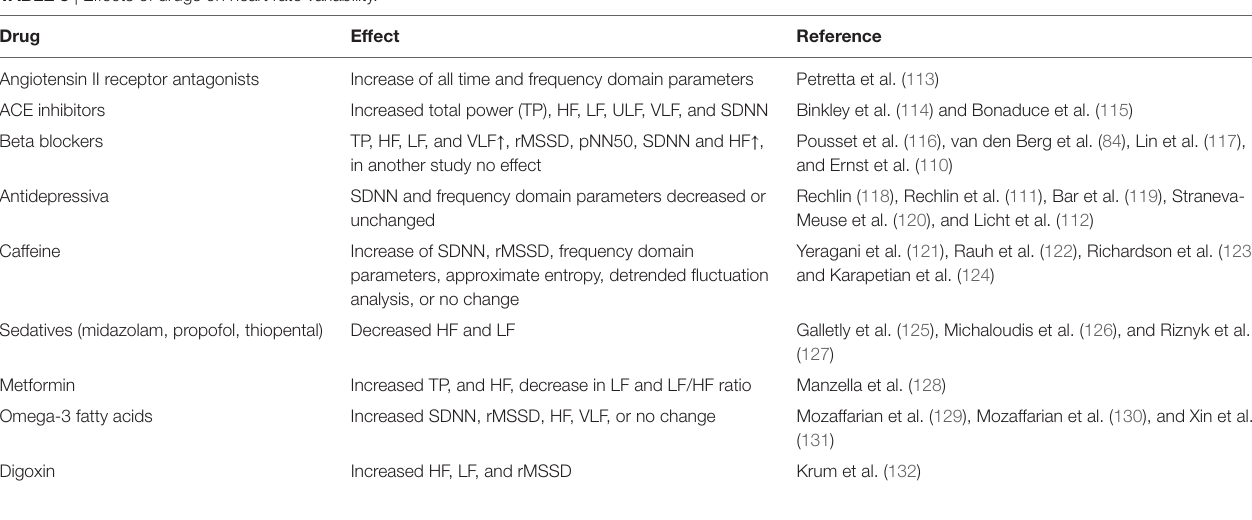
Table 3 | Effects of drugs on heart rate variability.